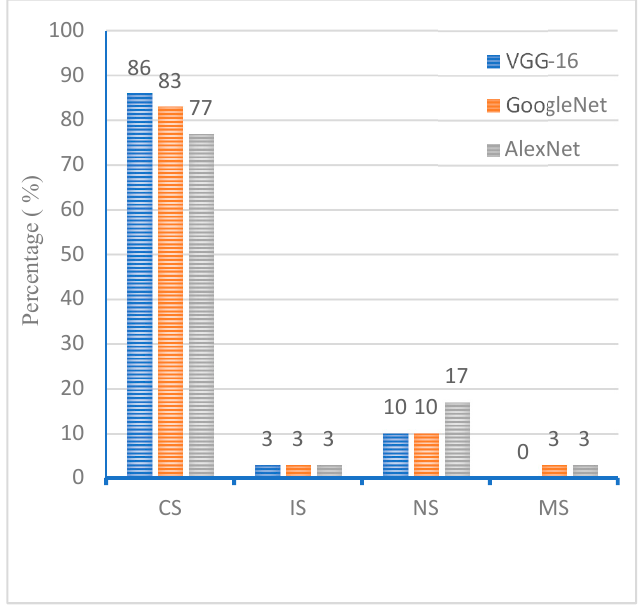
Figure 7. Graphical representation of precision spraying results with all three models.